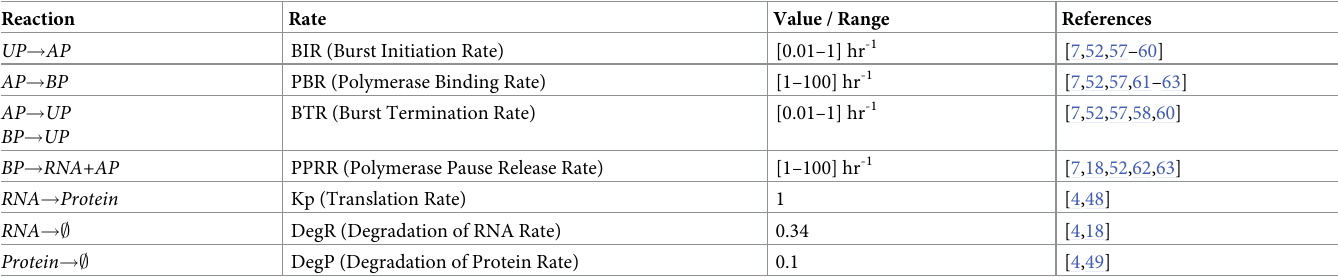
Table 1. Model development and parameter